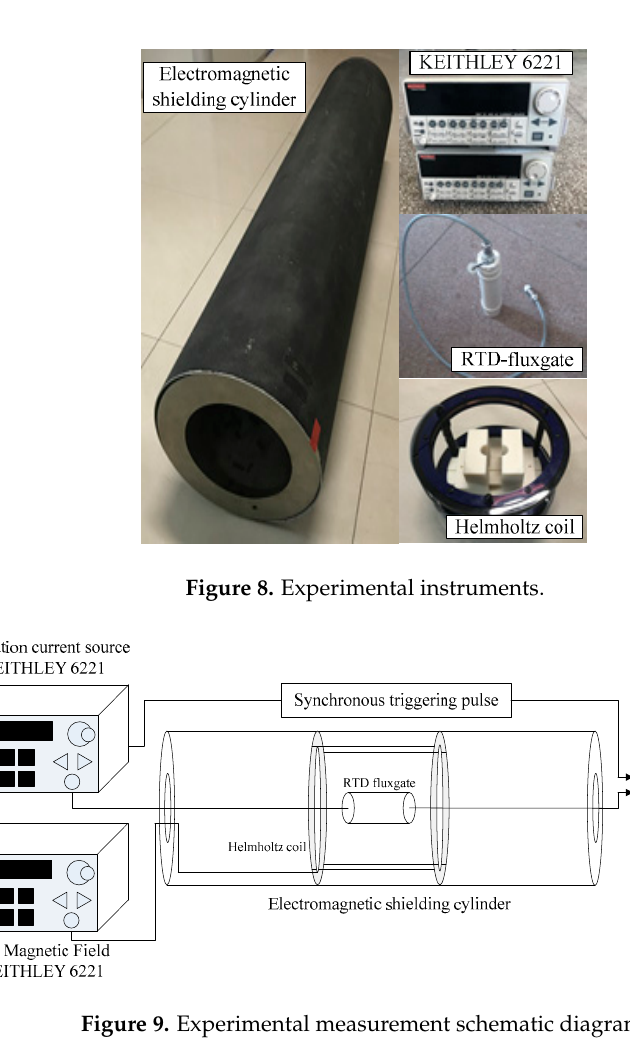
Figure 9. Experimental measurement schematic diagram.